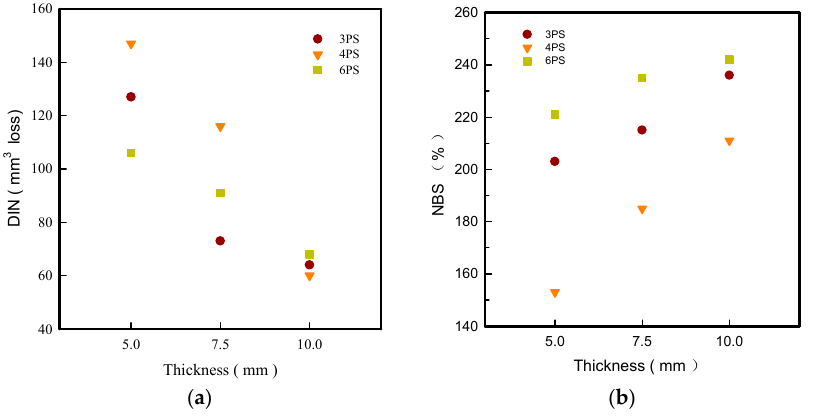
Figure 4. DIN ( a ) and NBS ( b ) abrasion of the LW 3DP 3-, 4-, and 6-SP outsole with various thick-